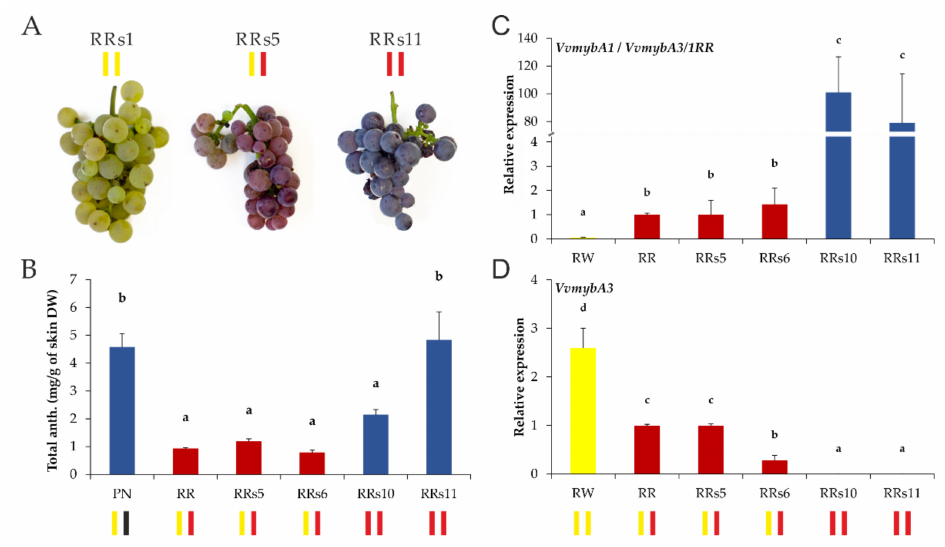
Figure 3. Total anthocyanin content and relative gene expression of VvmybA1 / VvmybA3/1RR and VvmybA3 of ‘Riesling Weiss’, ‘Riesling Rot’, and the self-cross line RRs in ripe berry skins. ( A ) Ripe bunches of the genotypes RRs1, RRs5, and RRs11 with differing haplotype constitutions at the berry color locus. ( B ) Total anthocyanin content in ripe berries. The classical red wine cultivar ‘Pinot Noir’ with dark blue berries is used as a reference. Data represent the mean values of three independent replicates; error bars represent standard deviation. Relative gene expression of VvmybA1 / VvmybA3/1RR ( C ) and VvmybA3 ( D ). Data represent the mean values of three indepen- dent replicates with normalization to the expression of RR (RW and RR) and RRs5 (RRs line); error bars represent standard errors. Colored bars represent the haplotype constitution at the berry color locus (yellow = white allele, red = red allele, black = wild type blue/black allele of typical red wine cultivars with functional VvmybA1 and VvmybA2 ). Different letters indicate statistically significant differences ( p -value < 0.05). PN = ‘Pinot Noir’; RR = ‘Riesling Rot’; DW = dry